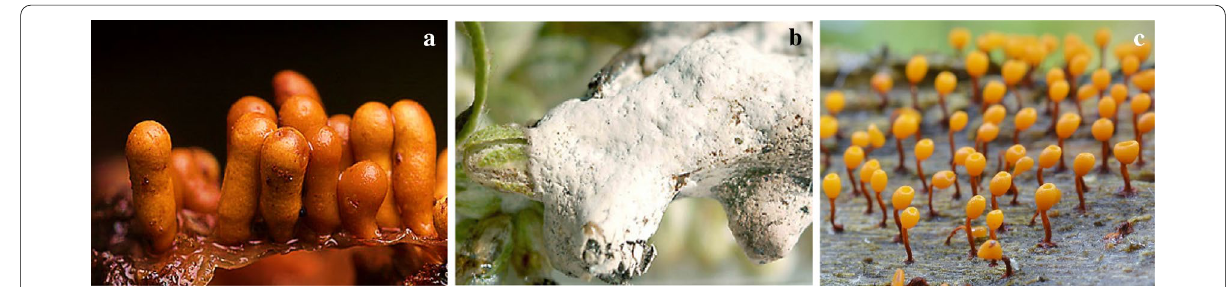
Fig. 7 a Trichia favoginea , b Fuligo cinerea , c Physarella oblonga (http:// www. sanam yan. com/ myxom ycetes, https:// www. disco verli fe. org, http:// mycow eb.